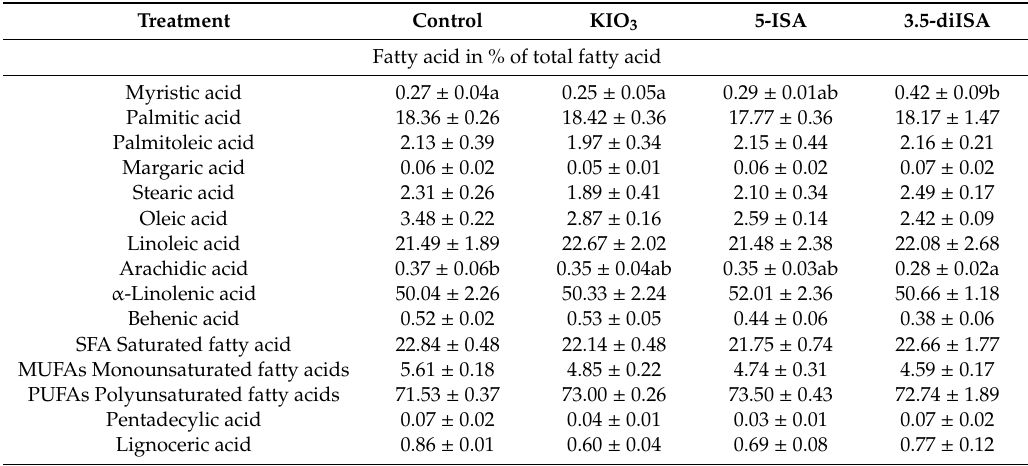
Table 2. Fatty acid profile (means for 2018–2019). 3.4-diISA: (4) 3.5-diiodosalicylic acid, 5-ISA: 5-iodosalicylic acid, PUFA: polyunsaturated fatty acids.